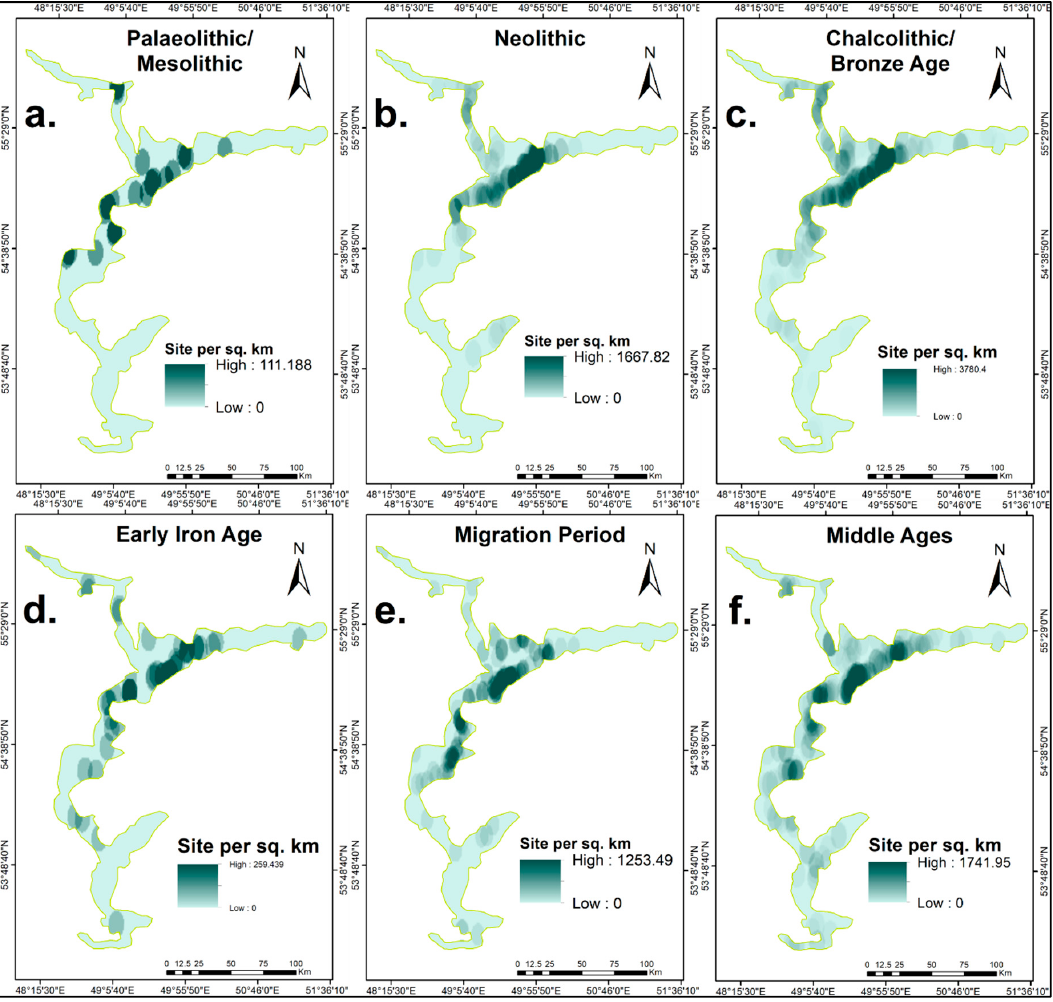
Figure 6. Location and density analysis for archaeological sites for the following periods: ( a ) Palaeolithic/Mesolithic; ( b ) Neolithic; ( c ) Chalcolithic/Bronze Age; ( d ) Early Iron Age; ( e ) Migration Period; ( f ) Middle